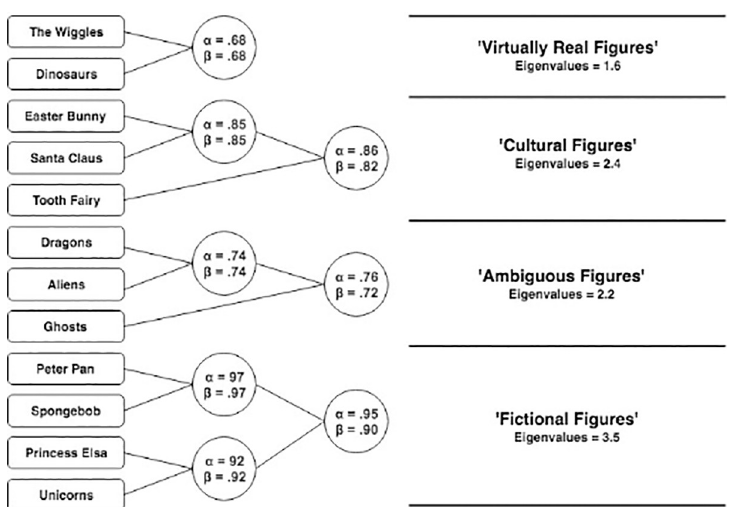
Fig 2. A 4-cluster solution of the child’s pantheon.